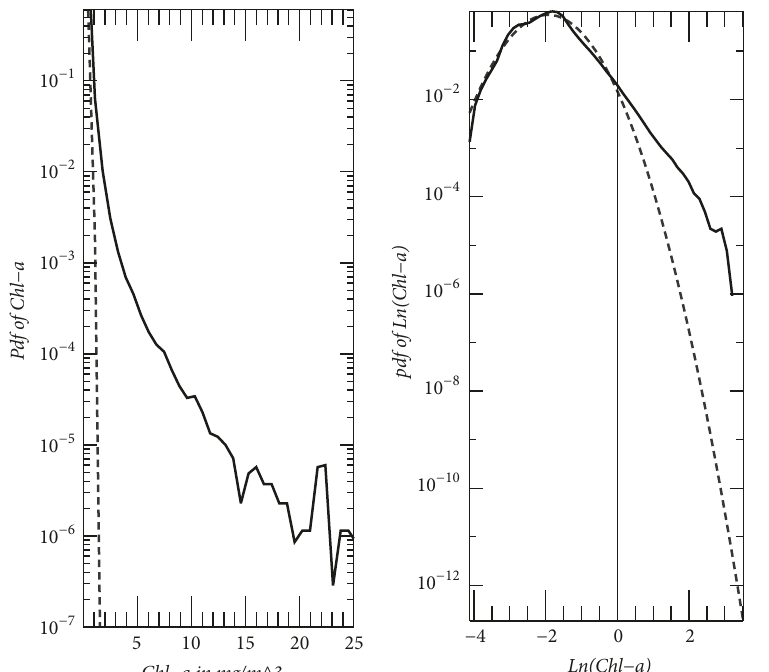
Figure 9: Probability distribution functions (PDF) of chlorophyll-a (solid line) and corresponding normal distribution (dashed line) having the same mean value and standard deviation: chl-a (left) and ln(chl-a) (right).